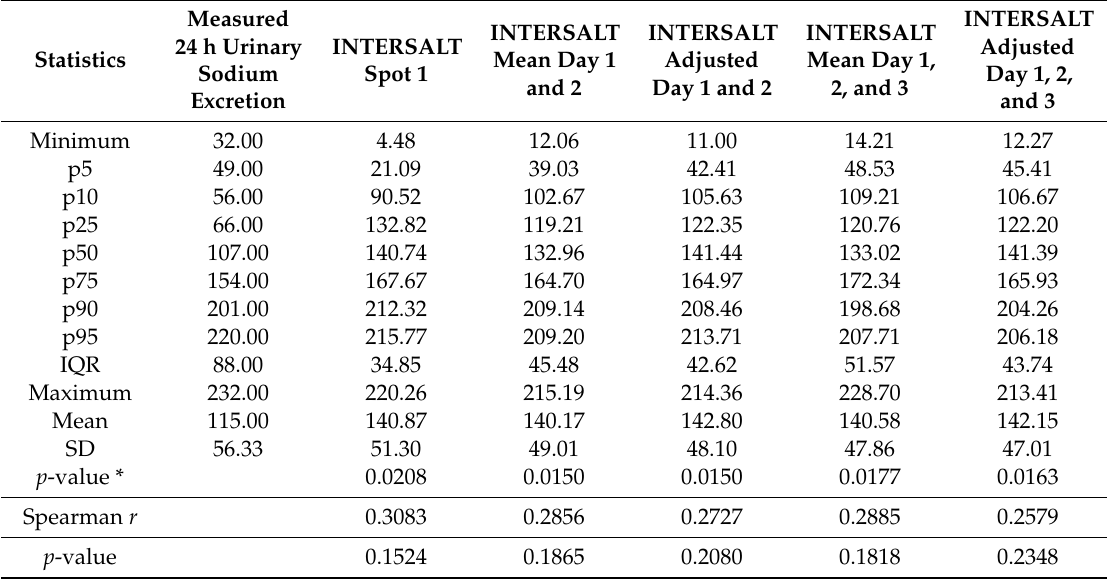
Table 4. Prediction equations to estimate 24 h Na using correction applied for both spot Na and spot Cr using the INTERSALT equation (mmoL /